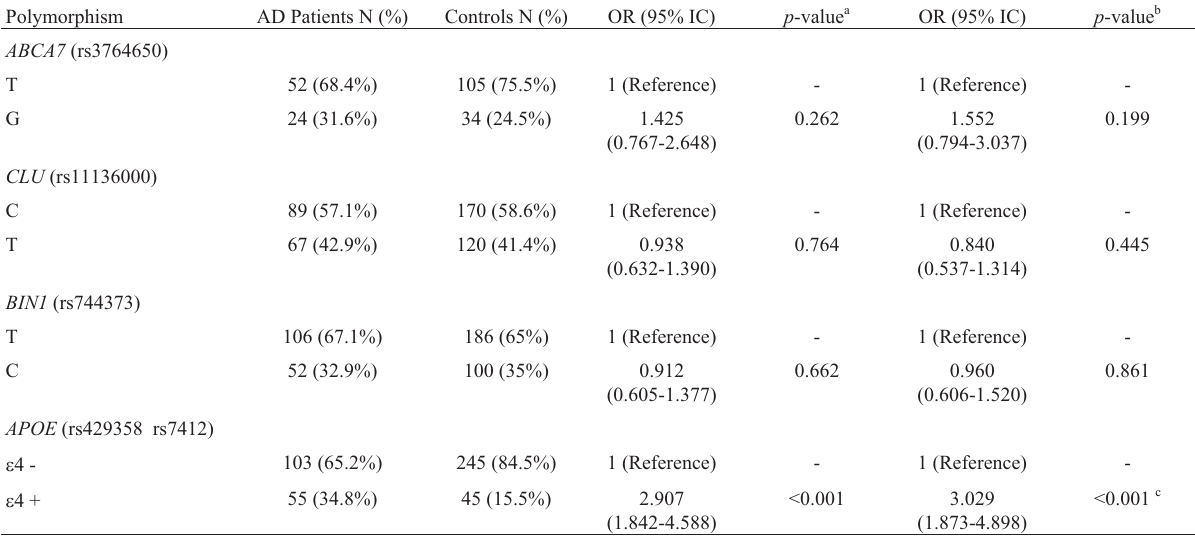
Table 2 - Test for independent interaction of SNPs with LOAD.